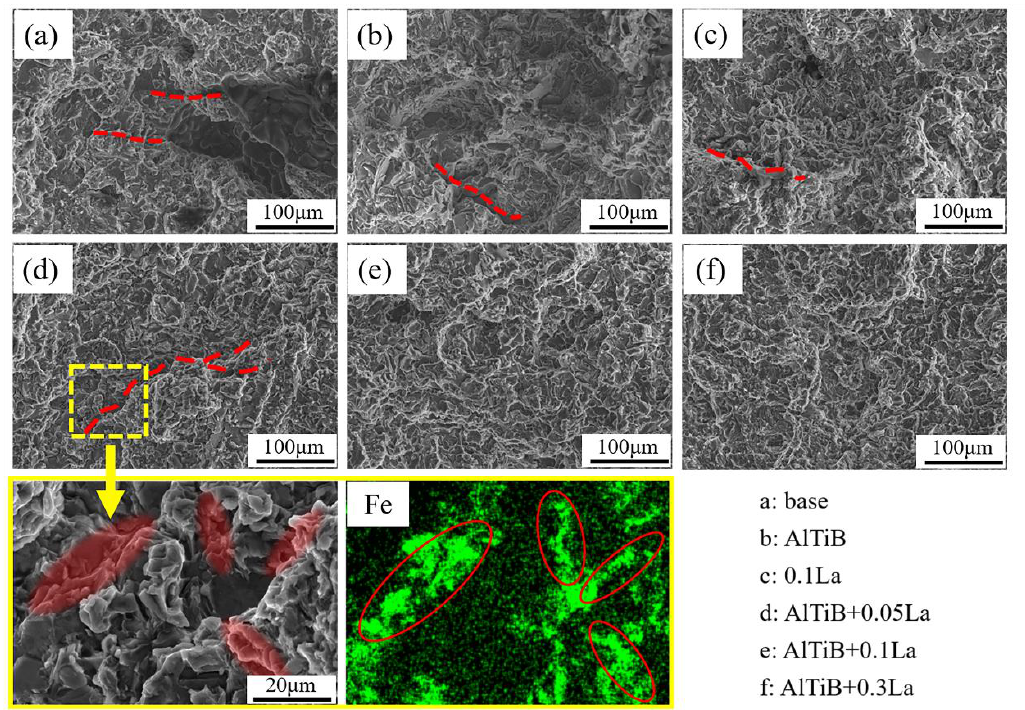
Figure 7. As cast typical fracture characteristics of 6 groups of alloys. ( a )base, ( b ) AlTiB, ( c ) 0.1La, ( d ) AlTiB + 0.05La, ( e ) AlTiB + 0.1La, ( f ) AlTiB + 0.3La.